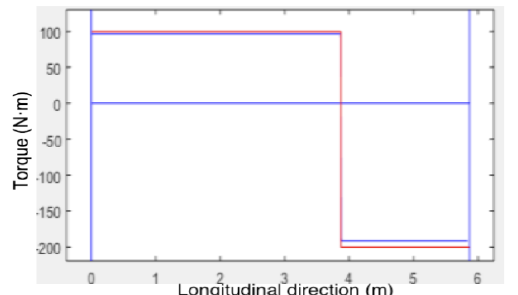
Figure 8. Torque obtained from the deformed point clouds for a concentrated load of 2000N applied 2 meters away from right end.